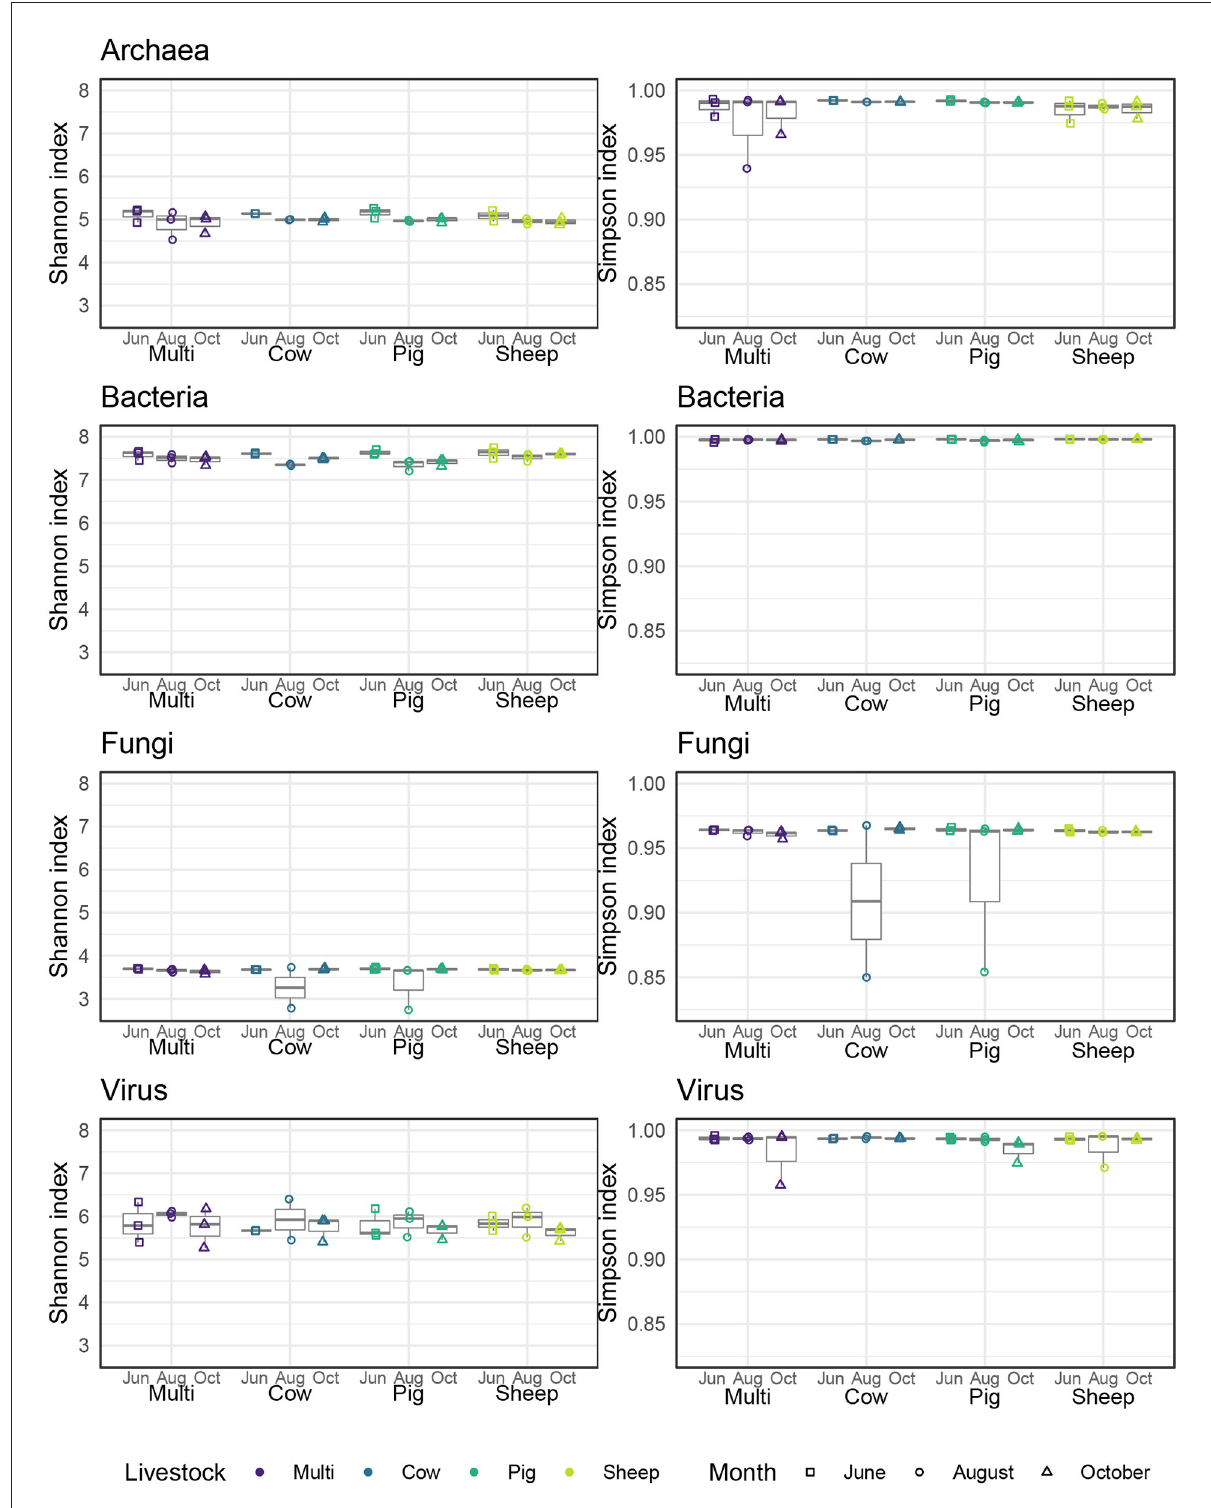
FIGURE4 Alpha diversity, as measured by Shannon and Simpson indices, for each microbial kingdom across livestock grazing treatments and